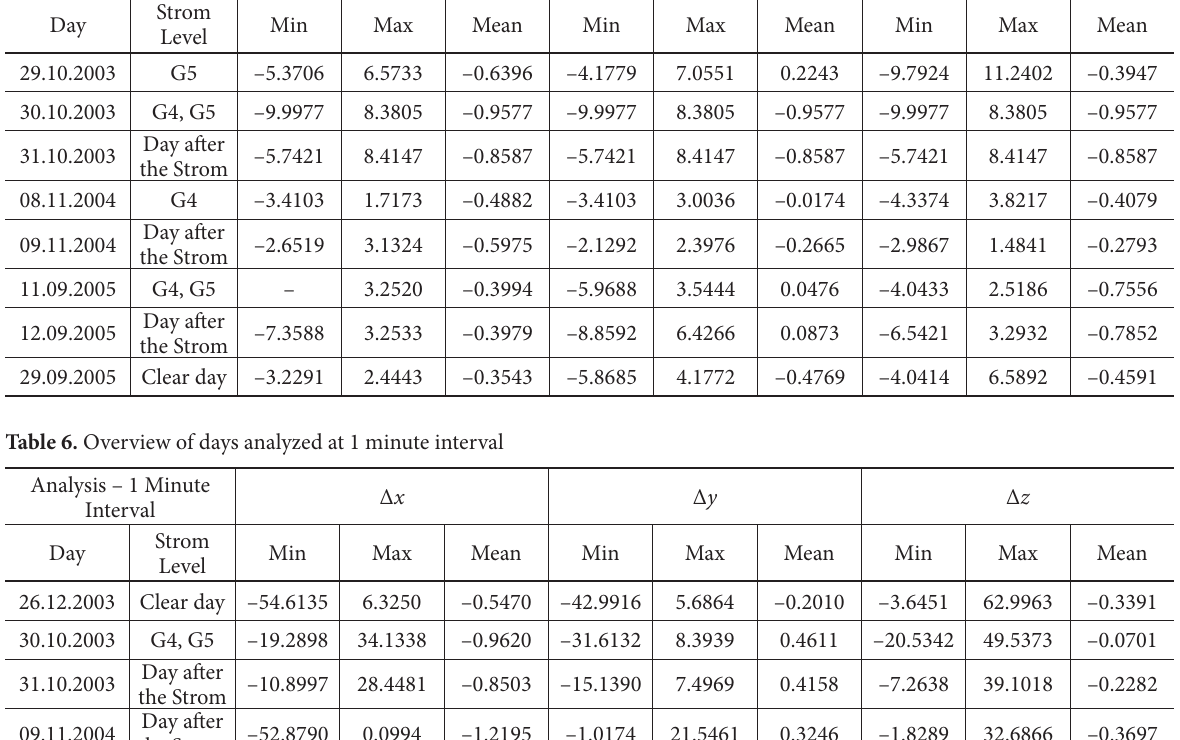
Table 5. Overview of days analyzed at 5 minutes interval Analysis – 5 Minutes Interval